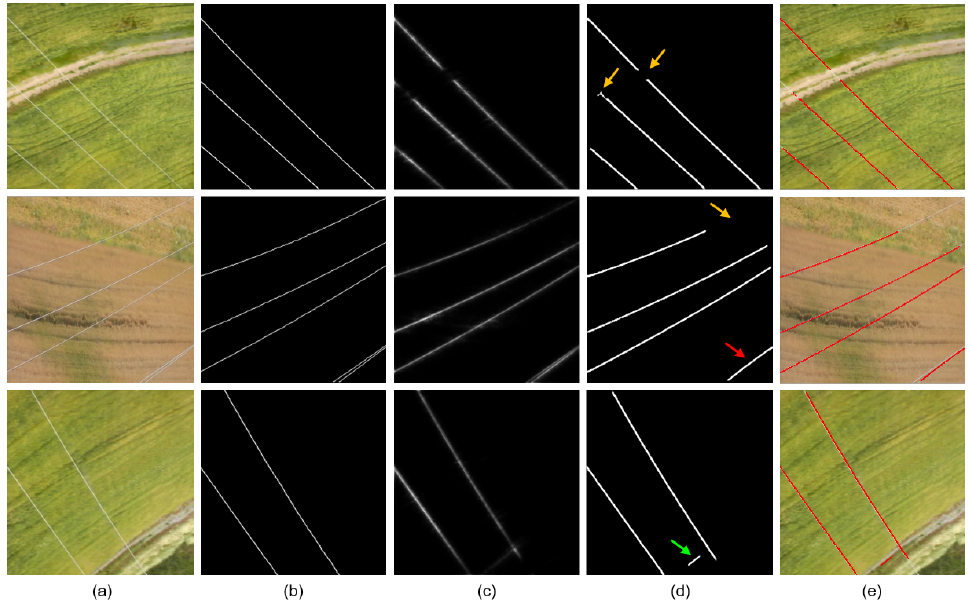
Figure 9. Examples of failure cases of the proposed method. The yellow and green arrows indicate missing parts of transmission lines and false positive responses, respectively. The red arrow indicates a false negative case for two transmission lines that are close to each other. ( a ) Original. ( b ) Ground truth. ( c ) ALM. ( d ) Refined ALM. ( e ) Overlaid image with the refined